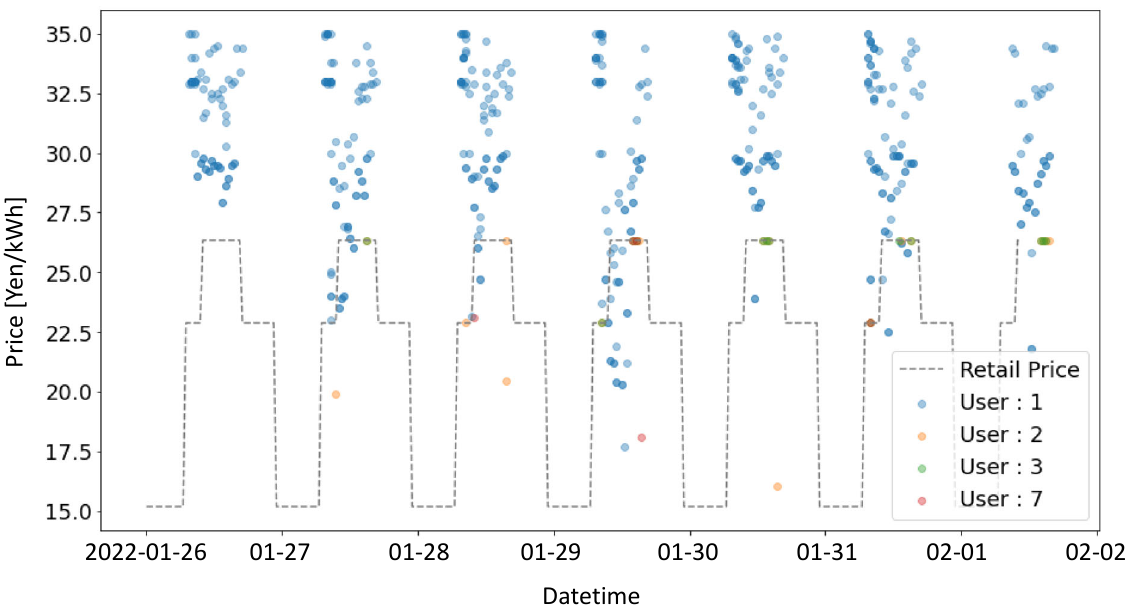
Figure 3. Trends in contract prices for all users in Phase 1 of the experiment.